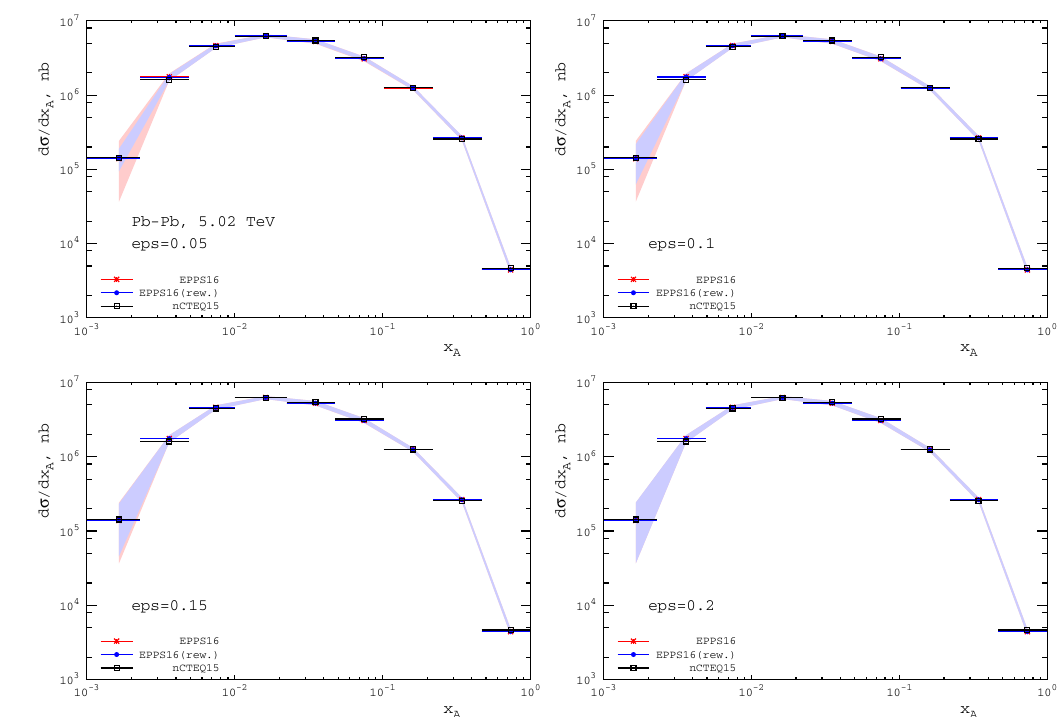
Fig. 9 Thedijetphotoproductioncrosssectionasafunctionof x A with (blue solid circles and error bands) and without (red crosses and error bands) the Bayesian reweighting calculated using the EPPS16 nPDFs;